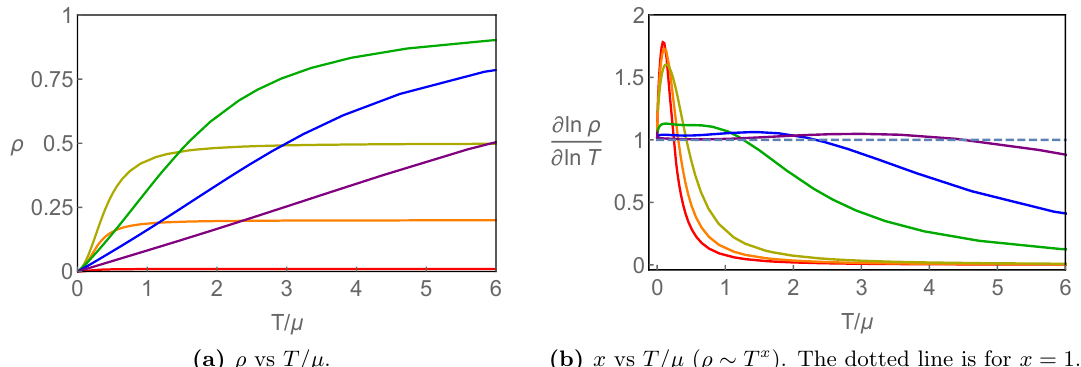
p p p 3 ; (cid:0) 2 = 3 ; 3) or